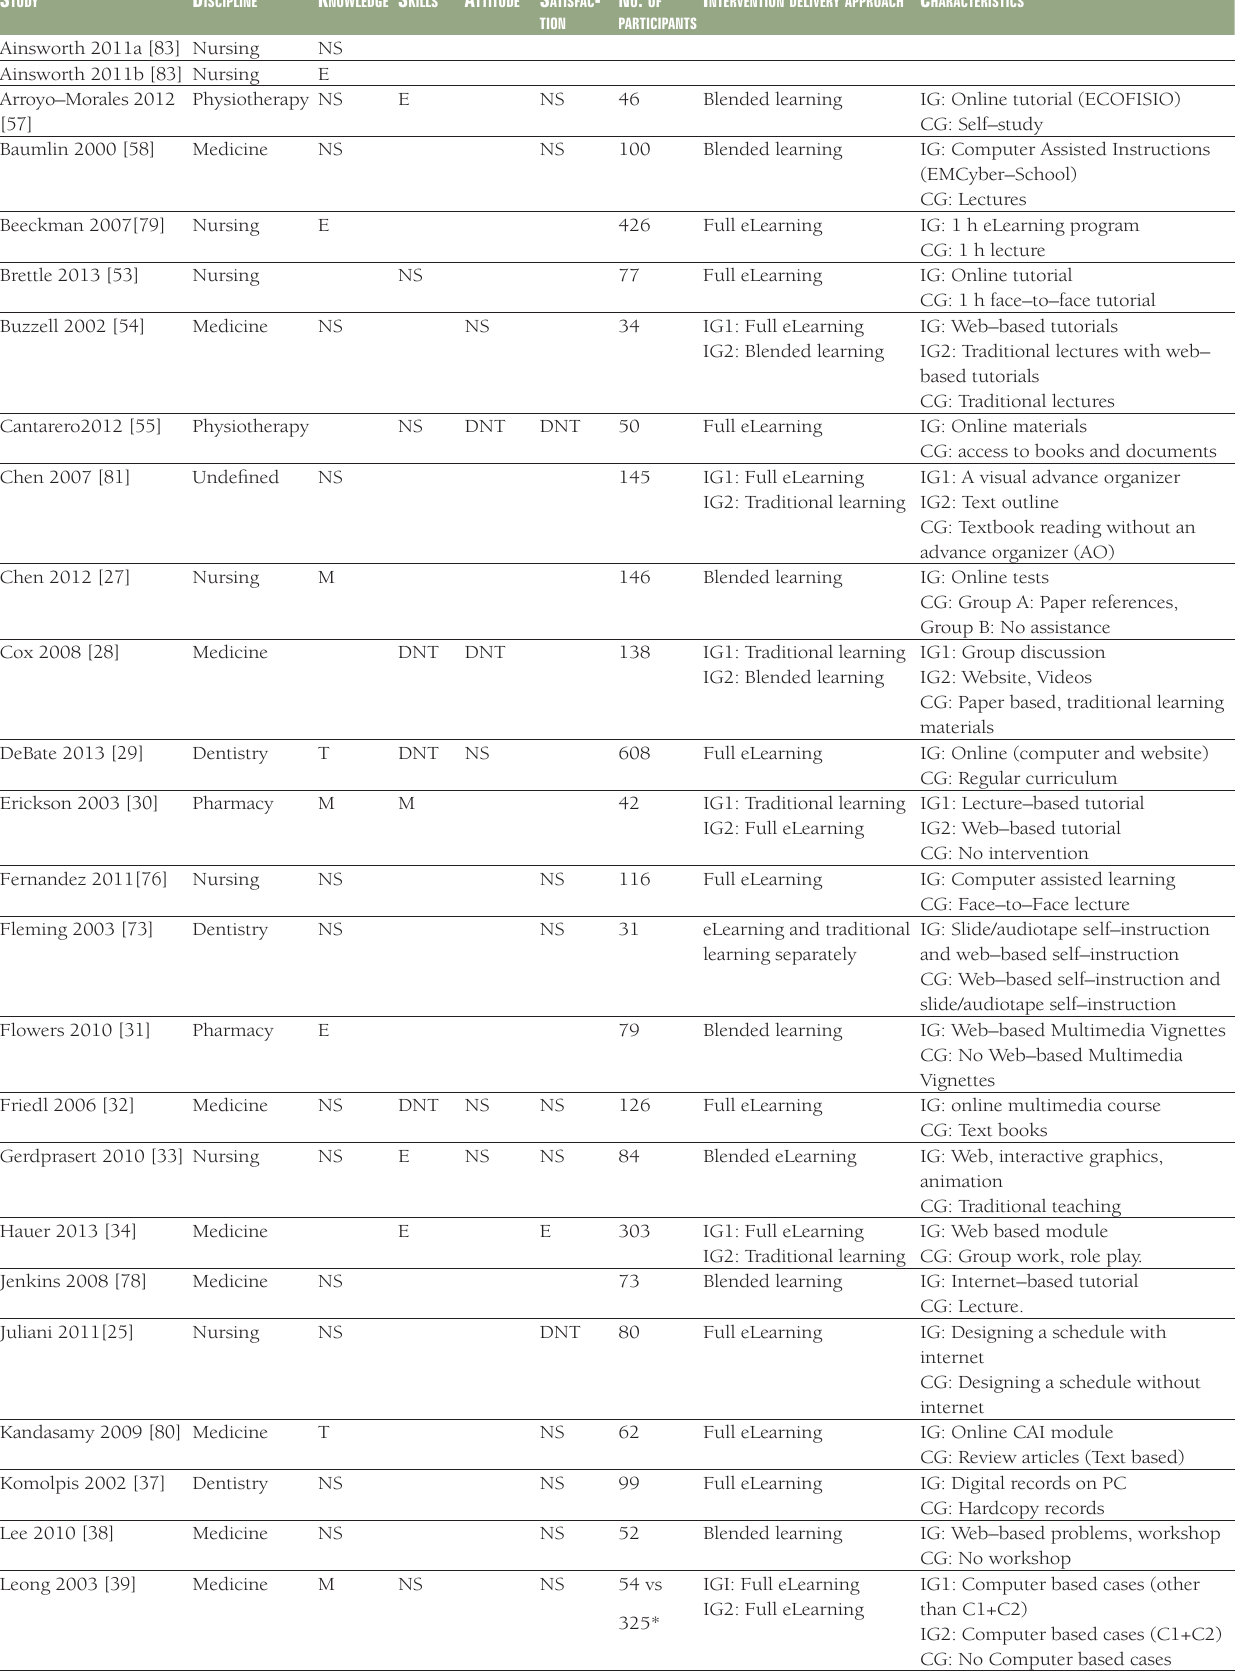
Table 2. Summary of findings from the 50 studies which compared online eLearning with traditional learning S